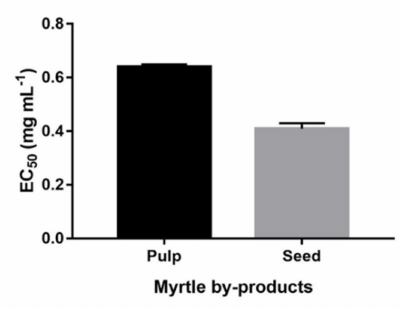
Figure 7. Hydroxyl radical scavenging activity of myrtle byproducts. Results are expressed as EC 50 (n =